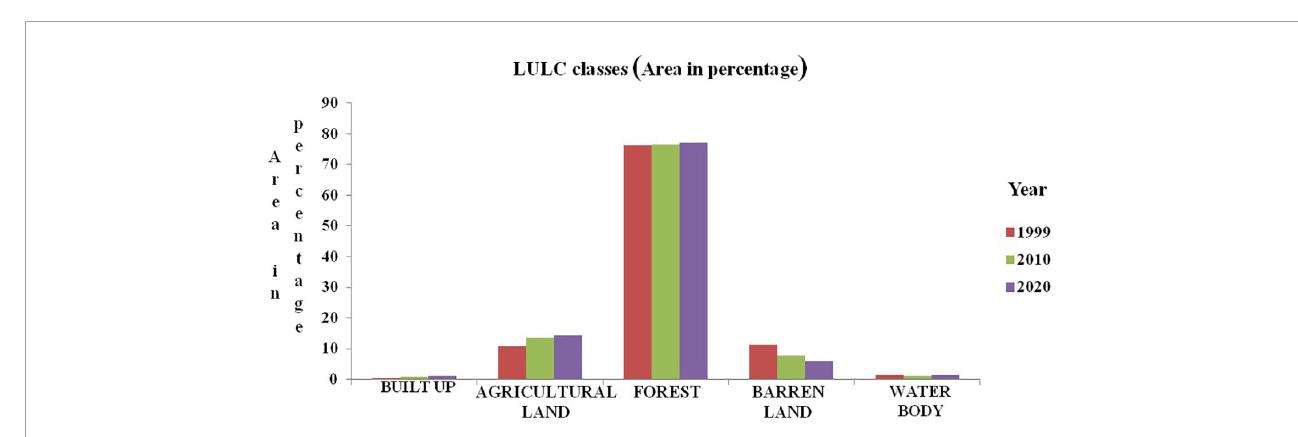
Frontiers in Forests and Global